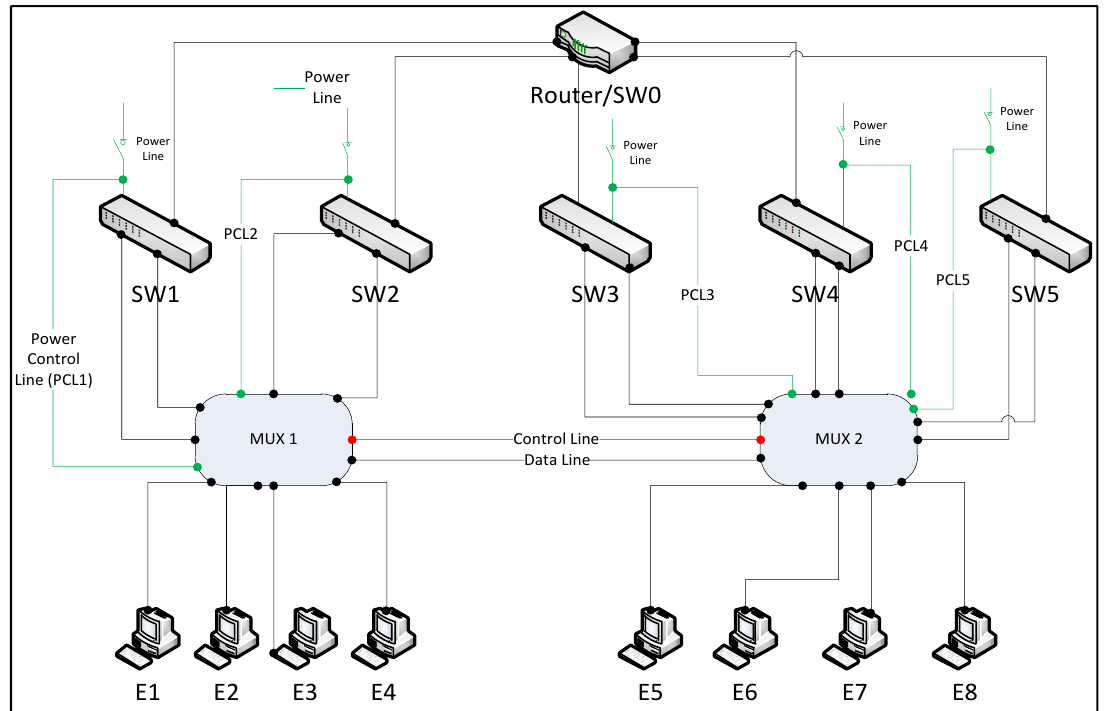
Figure 2. Position of MUXER in network topology.